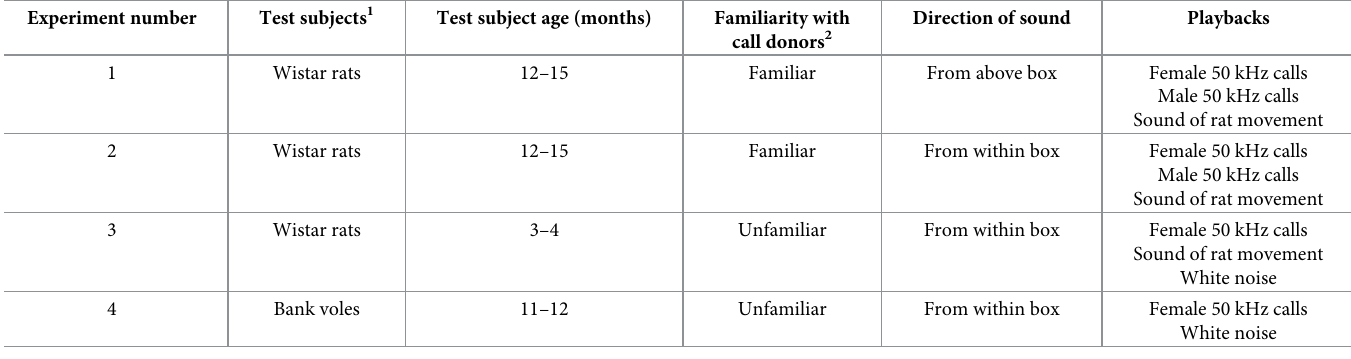
Table 1. Overview of